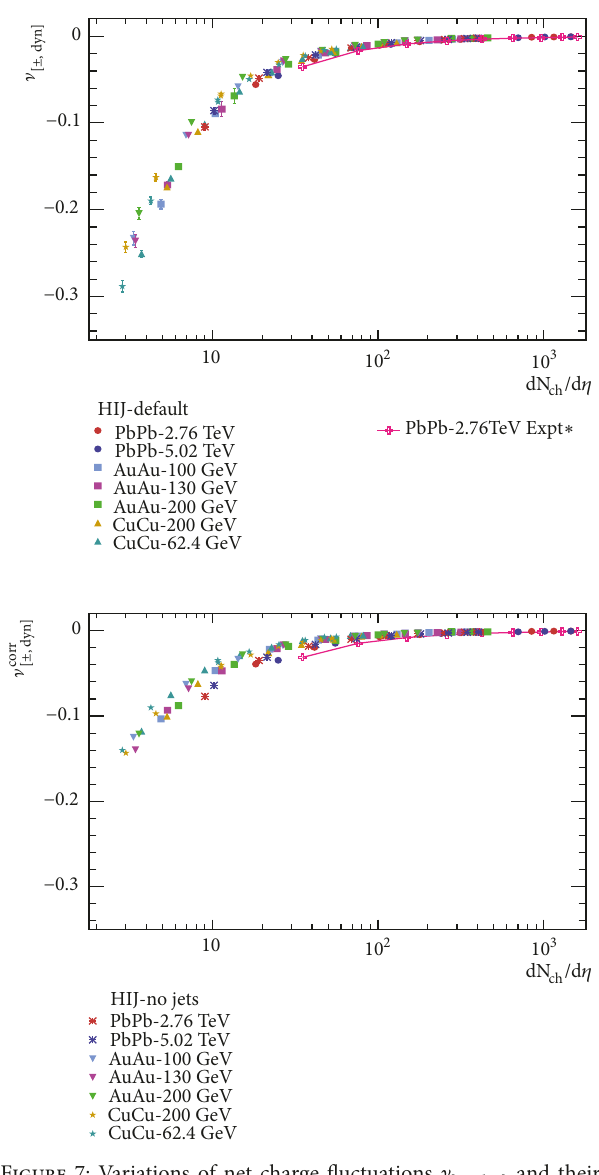
Figure 7: Variations of net charge fluctuations ] [+−,𝑑𝑦𝑛] and their corrected version, ] 𝑐𝑜𝑟𝑟 [+−,𝑑𝑦𝑛] , with charged particle density, 𝑑𝑁 𝑐ℎ /𝑑𝜂 , for the two sets of HIJING events. The lines are due to the 2.76 TeV Pb-Pb values taken from